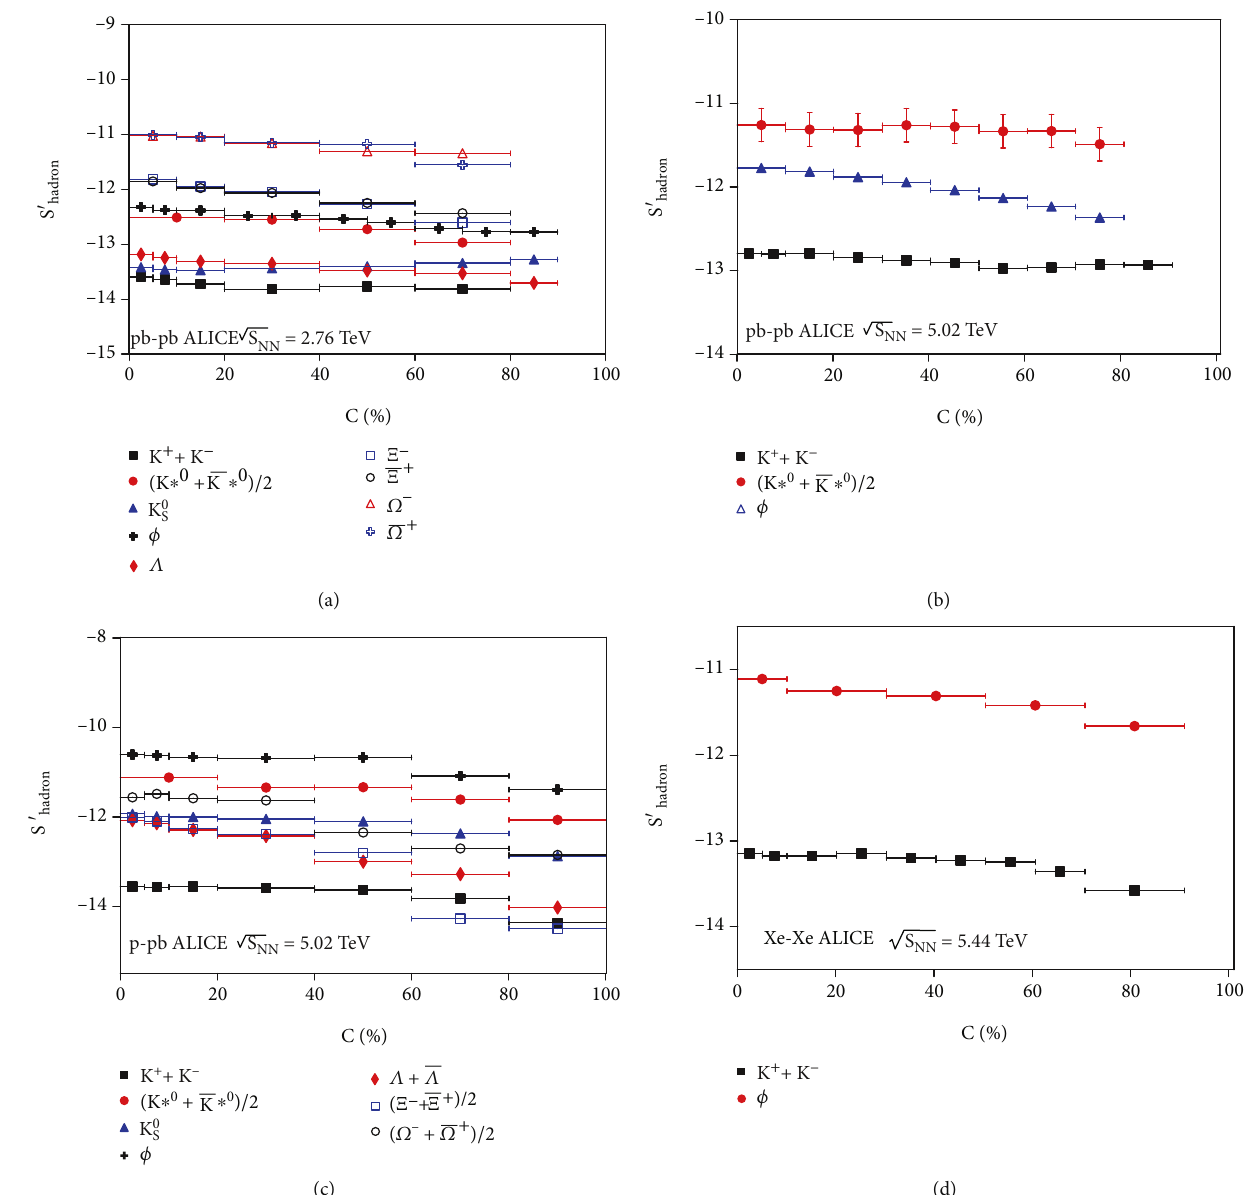
′ on centrality C in Pb – Pb, (c) p – Pb, and (d) Xe – Xe hadron